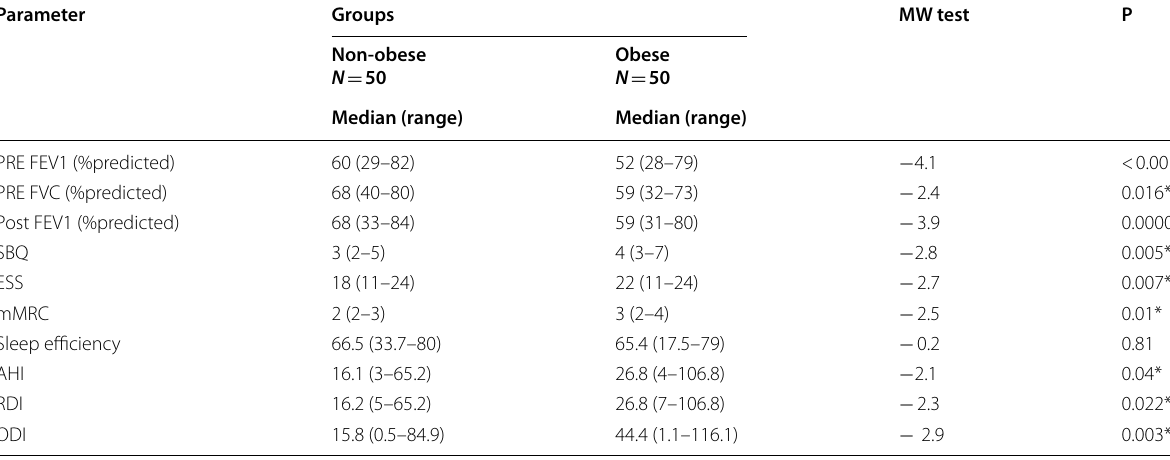
Table 2 Comparison of PFTs sleep questionnaire and sleep parameter between both